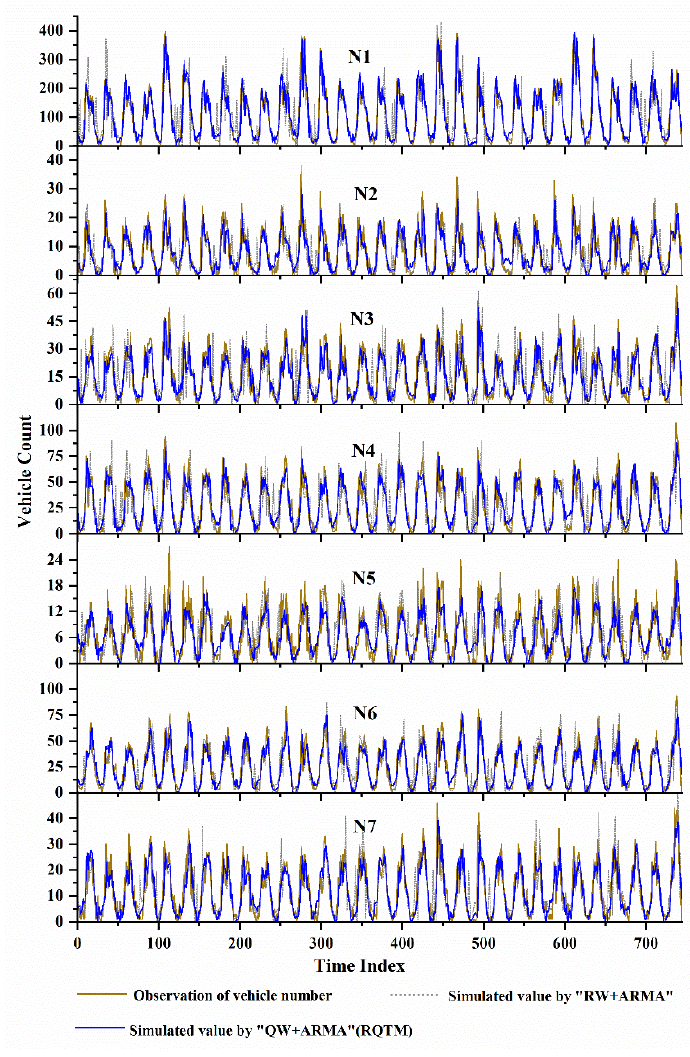
Figure 4. The simulation results of RQTM.